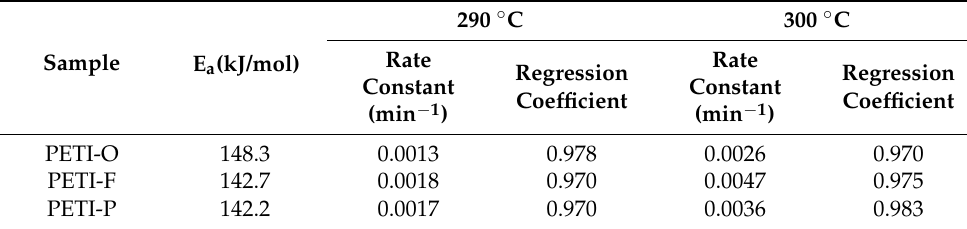
Figure 9. Kissinger plots of PETI-O, PETI-F and PETI-P at T β . Table 3. Kinetic parameters of PETI-O, PETI-F and